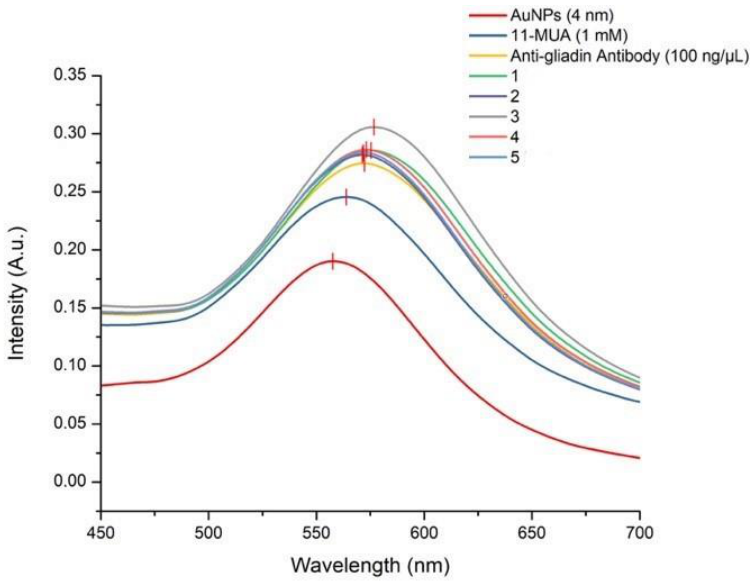
Figure 8. LSPR spectra of supernatants extracted from five food samples (1 to 5) in the presence of specific anti-IgG gliadin antibodies suspended in ddwater and immobilized on MUA/AuNPs formed on annealed coverslip. (A.u.—absorbance units)